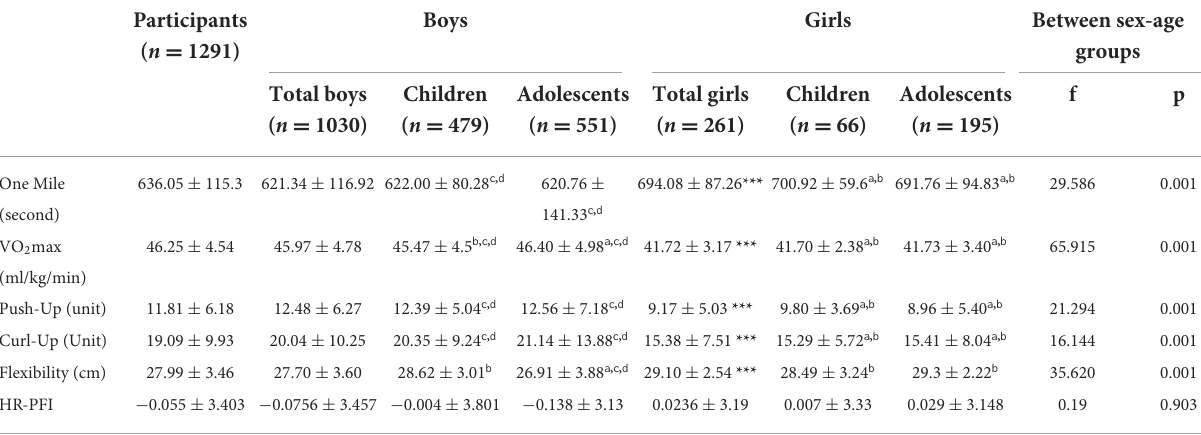
TABLE 3 Performances in physical fitness tests of participants stratified by sex and age